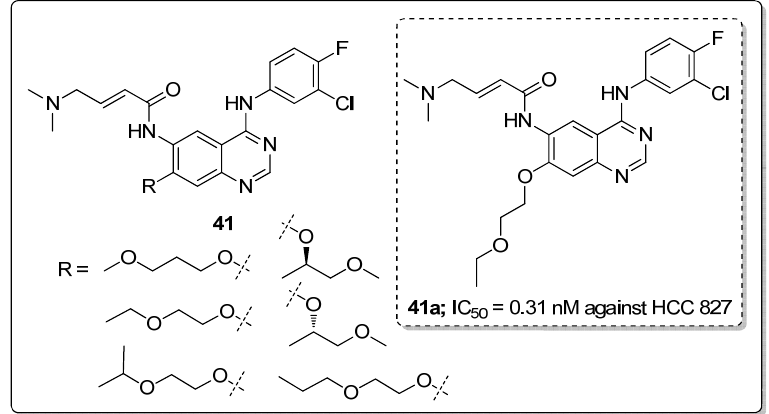
Figure 47. EGFR tyrosine kinase inhibitory activity of the most active quinazoline scaffold 41a .